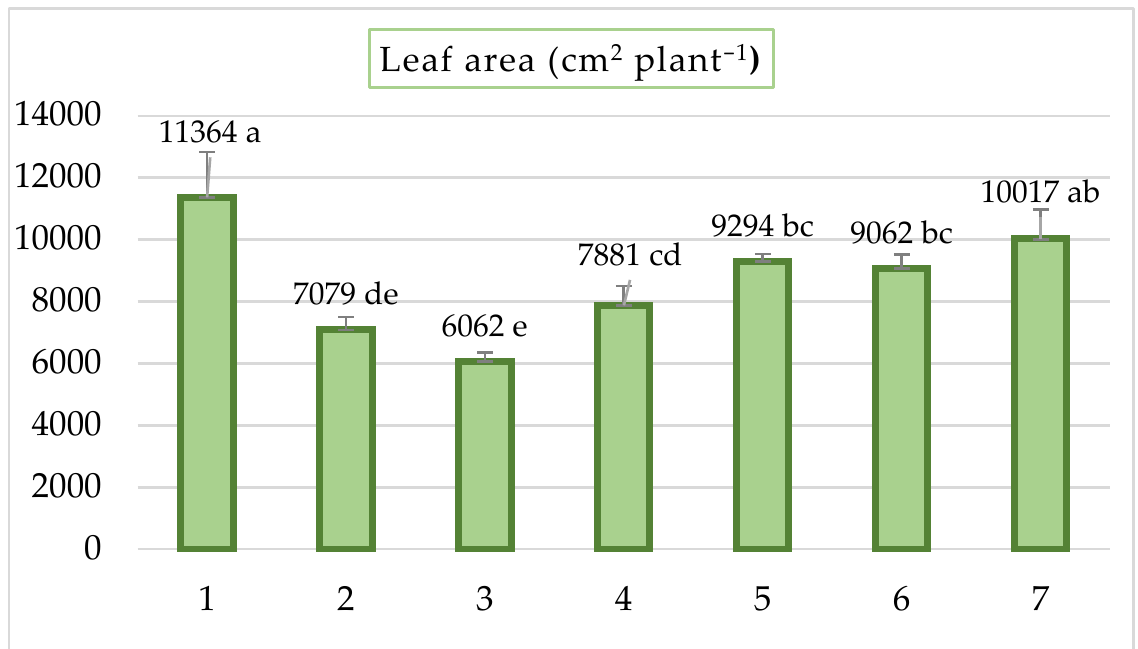
Figure 2. Effects of biofertilizers on pepper plant leaf area 164 DAT at the end of cultivation. DAT: day after transplanting. 1:100% MF, 2:60% MF + PGPR, 3:60% MF + AMF, 4:60% MF + PGPR + AMF,